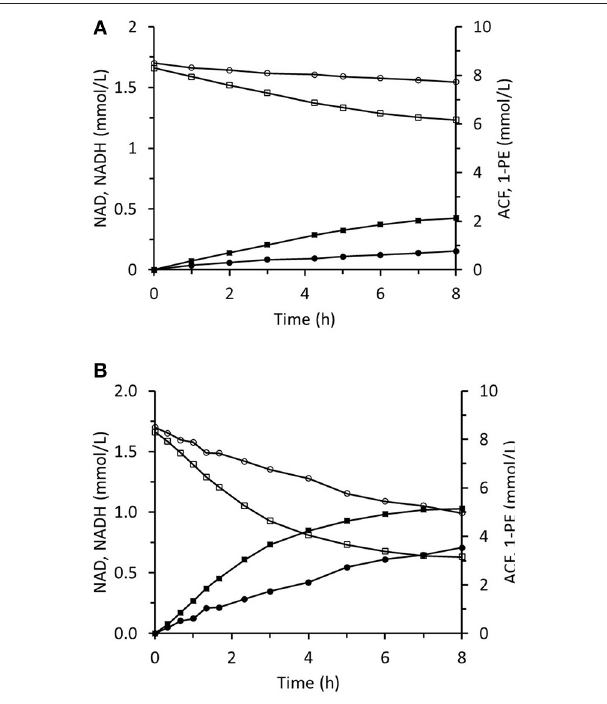
FIGURE 12 | Reaction course in the infinite recycling system with FDA and RrADH: (cid:4) - 1-phenylethanol; (cid:3) - acetophenone; • - NADH; ◦ - NAD. The volume of reaction solution in mixed reservoir was 18mL (A) and 6mL (B)